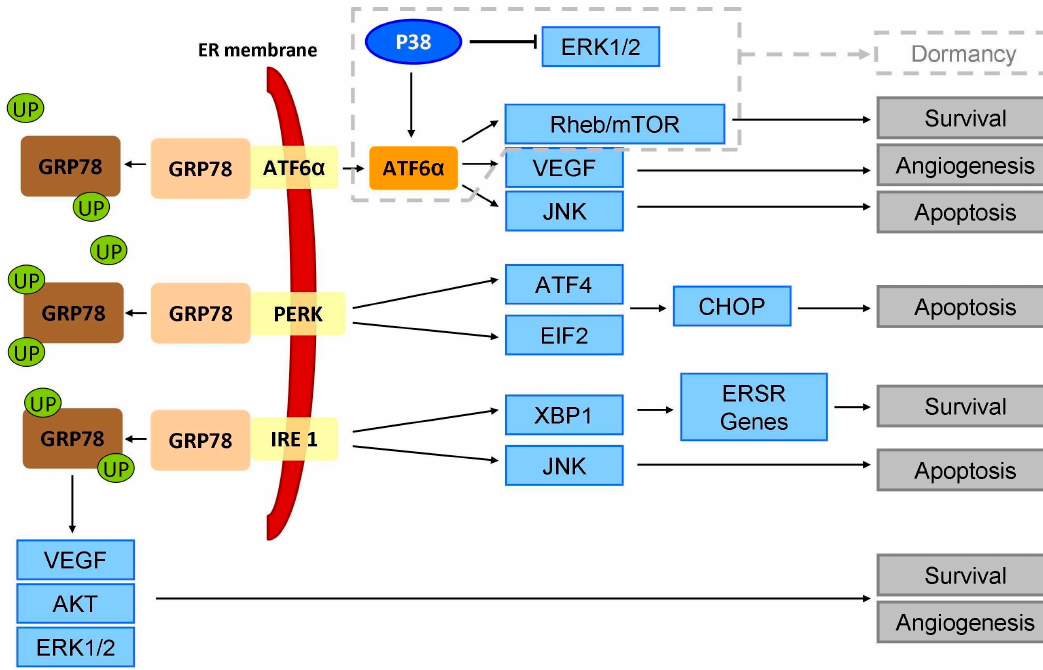
Figure 1. Consequences of endoplasmic reticulum stress response pathway. Unfolded protein accumulation and other stress conditions such as hypoglycemia and hypoxia cause the unbinding of GRP78 from ATF6 α , PERK, and IRE1. These three factors activate different signalling pathways that lead to survival or to apoptosis. UP: Unfolded proteins; ER: Endoplasmic reticulum; ERSR: Endoplasmic reticulum stress response; VEGF: vascular endothelial growth factor; AKT: AKT serine/threonine kinase; ATF4: activating transcription factor 4; CHOP: CCAAT/enhancer binding protein (C/EBP)-homologous protein; JNK: c-Jun N-terminal kinase; EIF2: eukaryotic initiation factor 2; XBP1: transcription factor X-box 1.